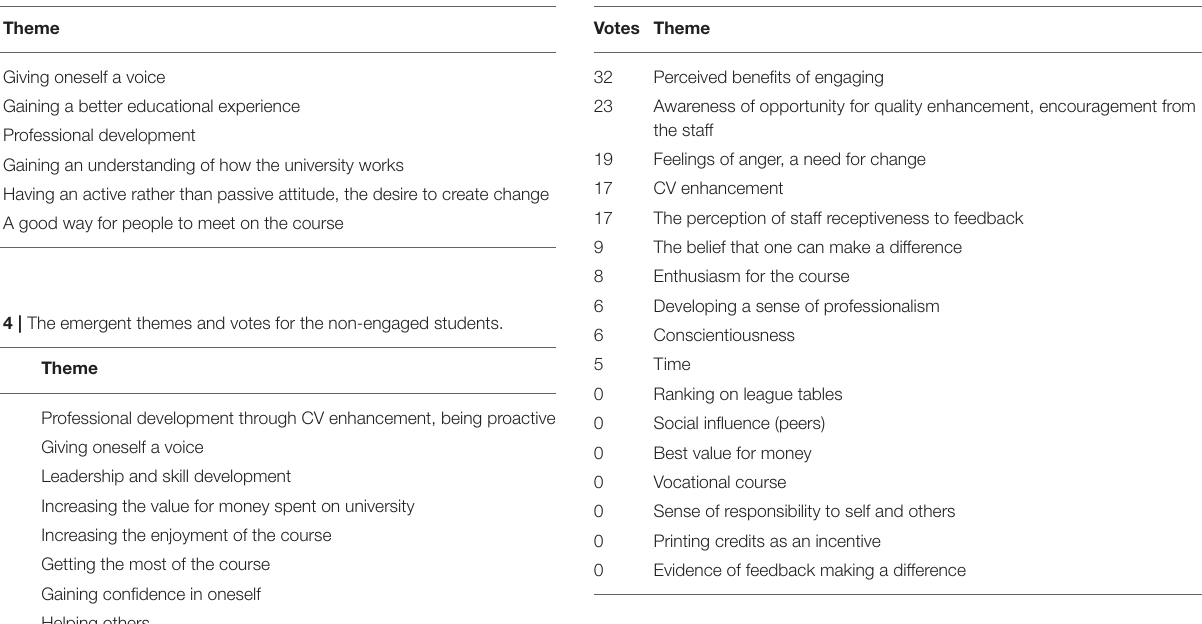
TABLE 5 | The emergent themes and votes for the student facing